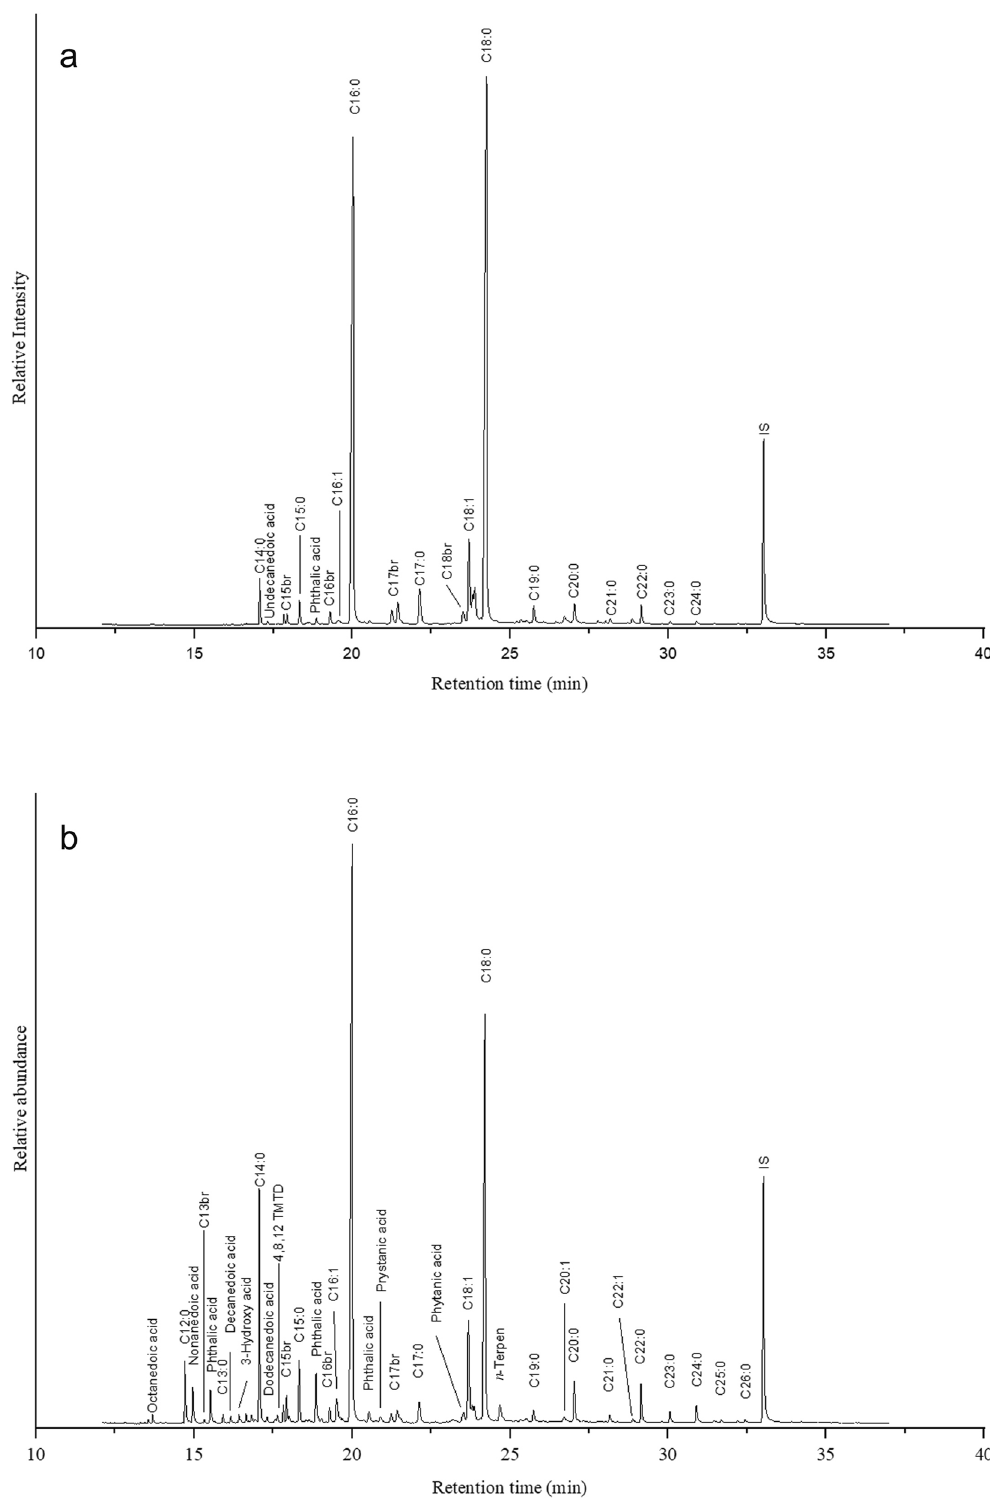
Figure 3. Partial gas chromatograms of TLEs from two Sorath Harappan potsherds from the site of Kotada Bhadli. Peaks were identified by GC–MS. Numbers ( X:Y ) refer to chain lengths ( X ) and number of saturation ( Y ) in the methanolic H 2 SO 4 extracts of the fatty acids; br indicates the presence of branched chain fatty acids and IS is the internal standard. ( a ) is the partial gas chromatogram of KB-171 indicating degraded animal fat and ( b ) is the partial gas chromatogram of KB-106 indicating degraded possible aquatic